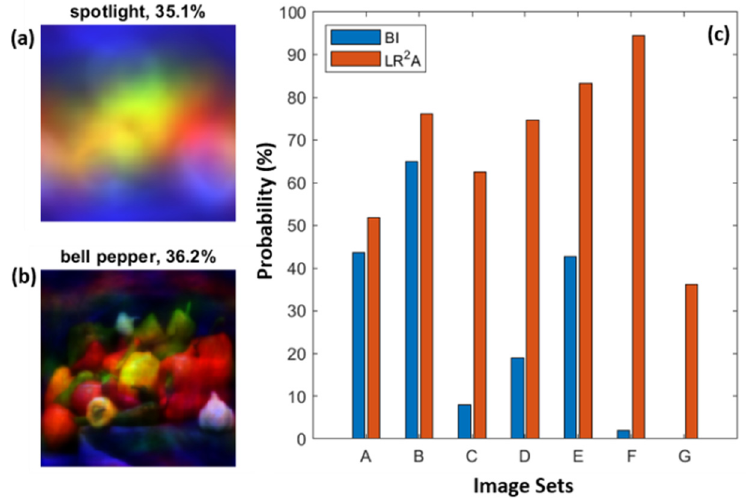
Figure 11. Image classification using GoogLeNet deep learning module ( a ) object intensity for image at ∆ λ = 132.8 nm, ( b ) deblurred image using LR 2 A ( a , c ) classification probabilities of blurred images (BI) vs. deblurred images (LR 2 A).